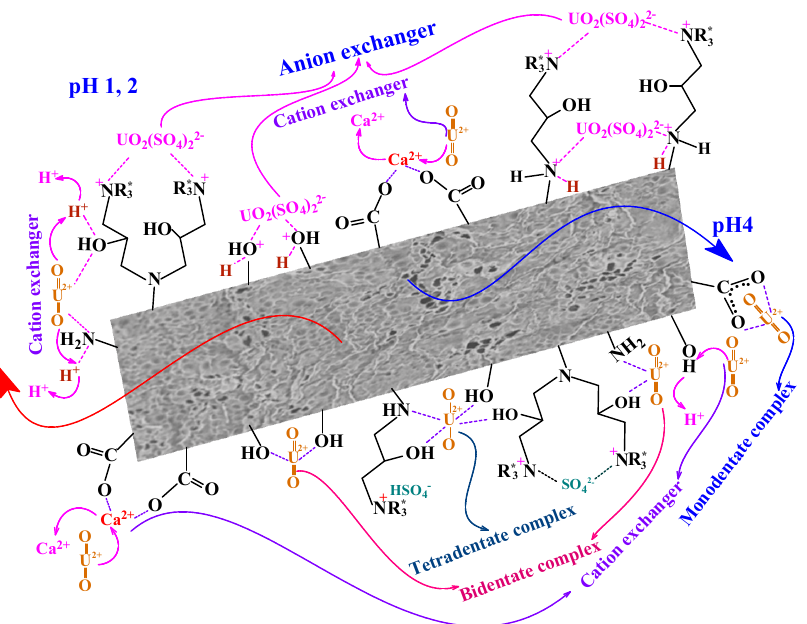
Scheme 1. Tentative mechanism for U(VI) sorption on Q-APEI.